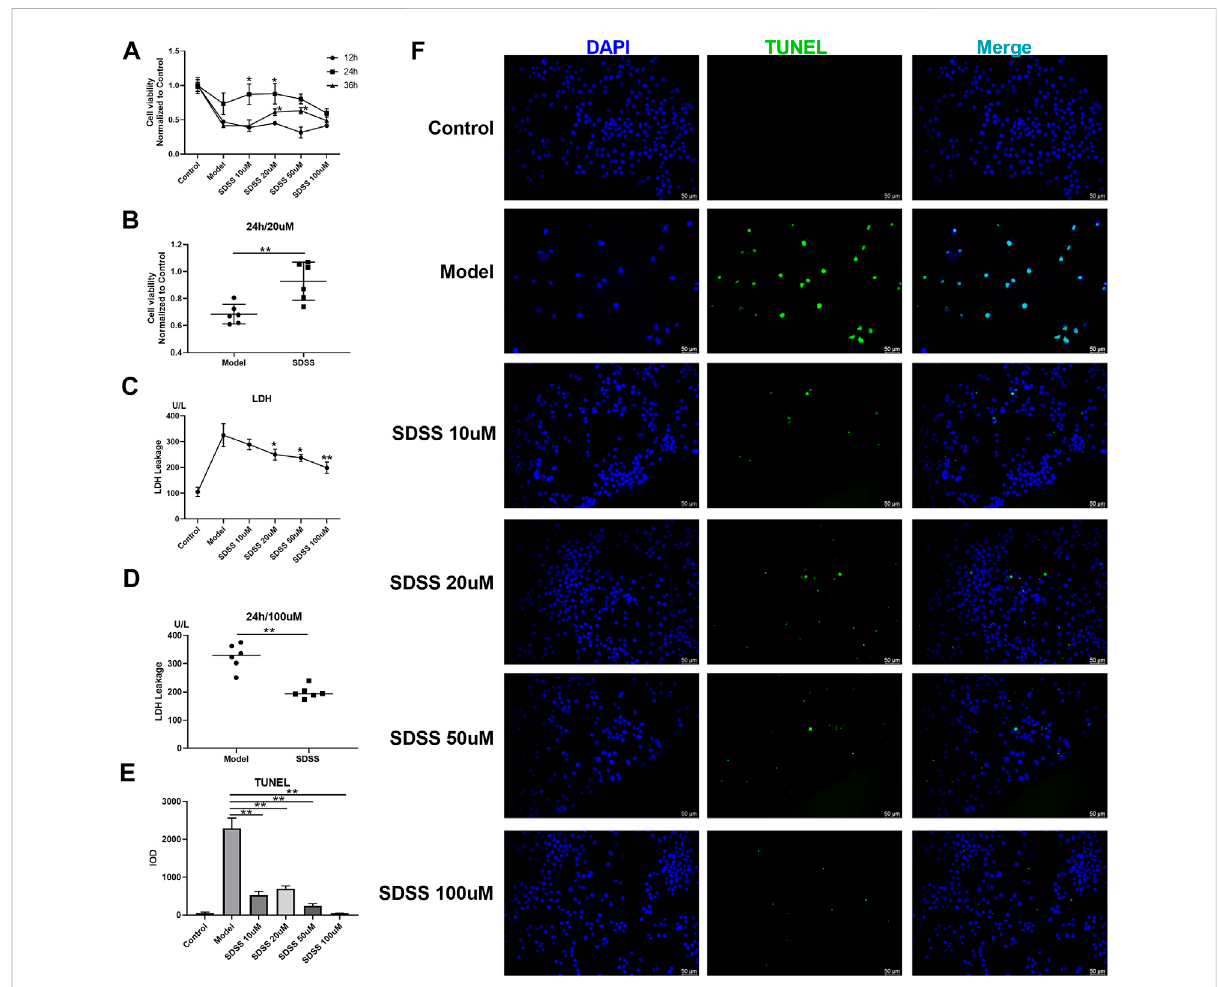
FIGURE 1 SDSS enhanced cell viability and attenuated ischemia/reperfusion – induced cell apoptosis and LDH release. P12 cell lines were exposed to oxygen-glucose deprivation for 2 h, then were subjected to reoxygenation for either 12 h, 24 h, or 36 h. Cell viability was detected by the CCK8 kit. Cells were treated with 10 μ M, 20 μ M, 50 μ M, or 100 µM SDSS in the reoxygenation stage. The time course of cell viability (A) and 20 µM SDSS intervention for 24 h (B) in response to ischemia/reperfusion; LDH leakage under different concentrations of SDSS for 24 h; (C) LDH leakage following 100 µM SDSS intervention for 24 h (D) ; (E) The integral optical density (IOD) of TUNEL staining. Five images in each group were used to calculate IOD; (F) Cell apoptosis rate was detected by TUNEL assay. Number of replicates = 3. Scale bar = 50 µm * = compared to model group, p < 0.05; ** = compared to model group, p <